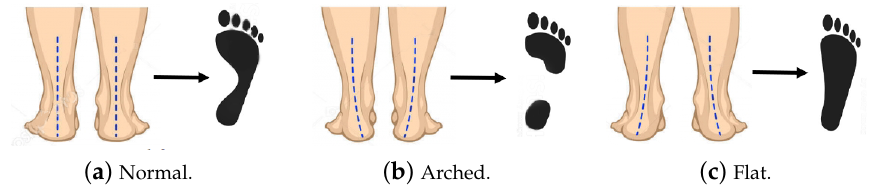
Figure 1. The three most common types of footprint shapes. ( a ) Normal, ( b ) arched, and ( c )